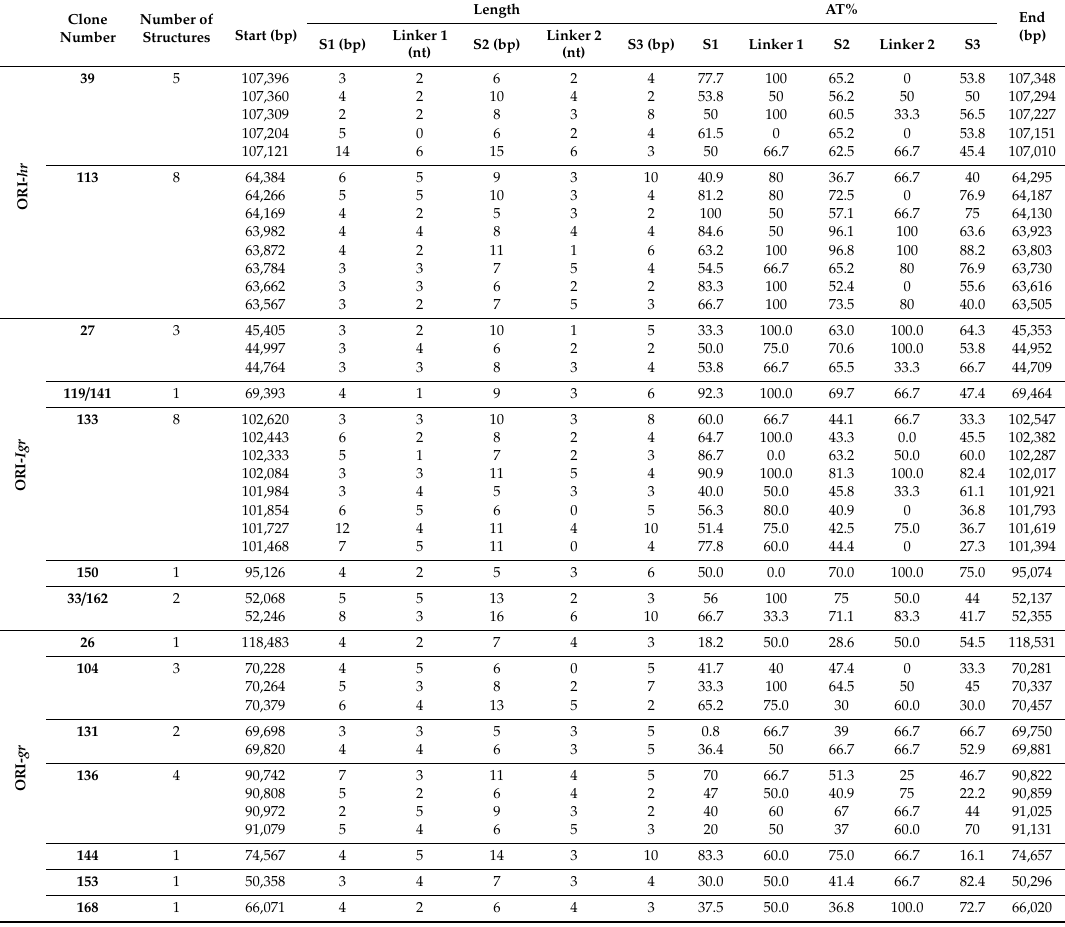
Table 3. Putative DNA structures of AgMNPV